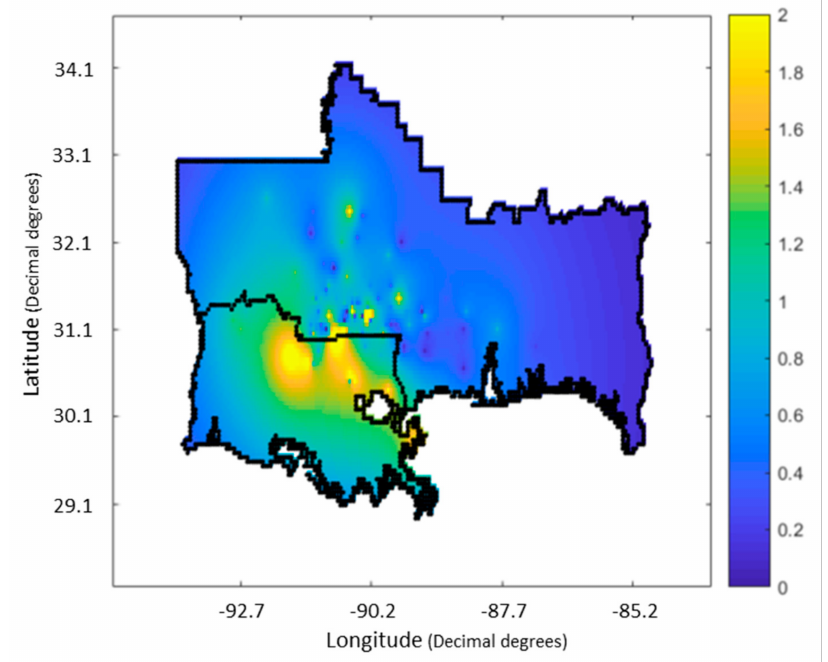
Figure 7. Spatial distribution of the 95% percentile TOC wt% values of the cumulative distribution function at each estimation